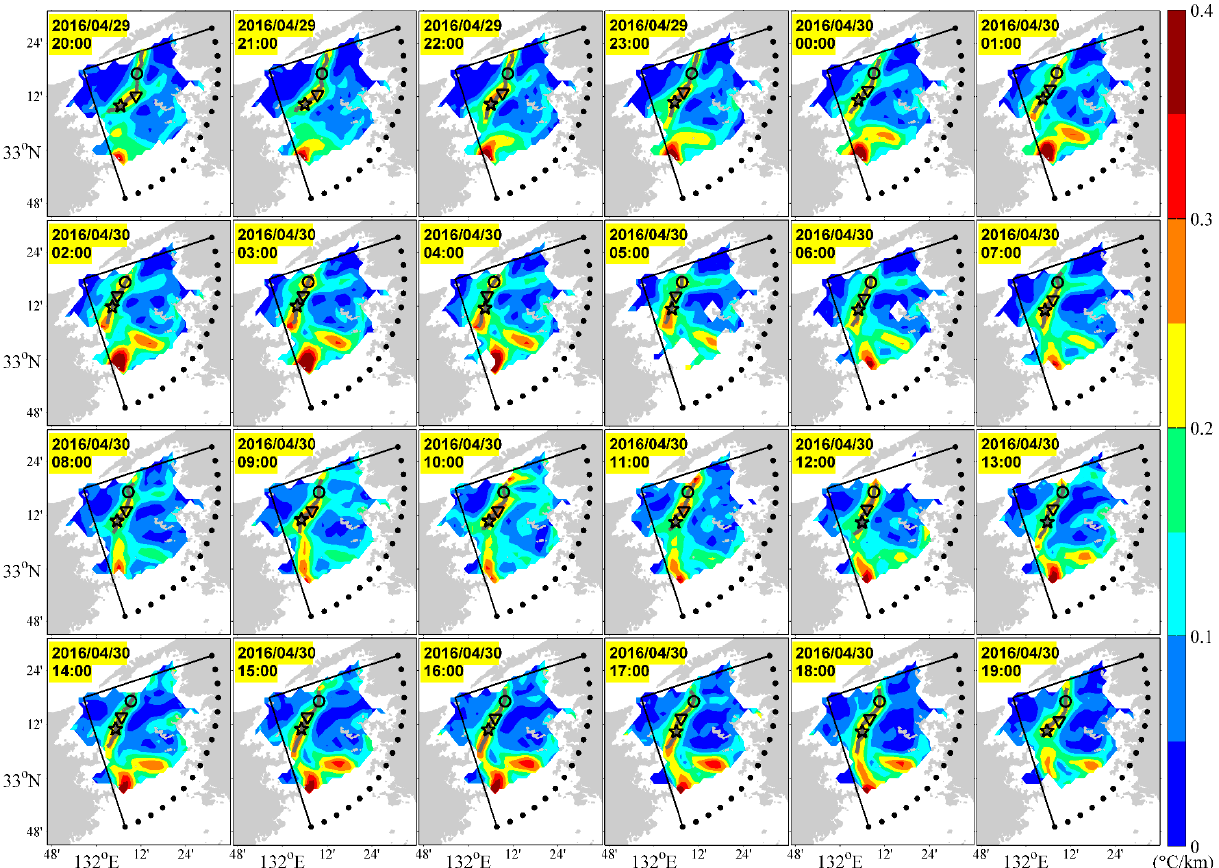
Figure 4. SST gradient magnitudes of the continuous hourly SST data from 20:00 29 April to 19:00 30 April 2016, during neap tide. The thick black lines indicate the position of the tidal front, and the star, triangle, and circle denote three representative